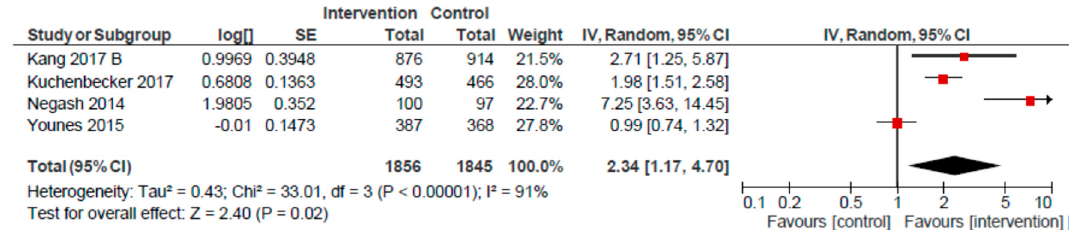
Figure 3. Forest plot of the meta-analysis of child minimum dietary diversity for mother/peer groups.